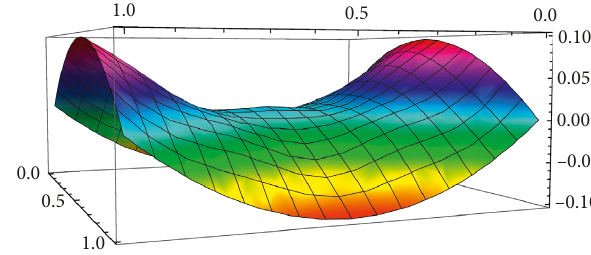
Figure 19: Third order ( t � 0.002s).